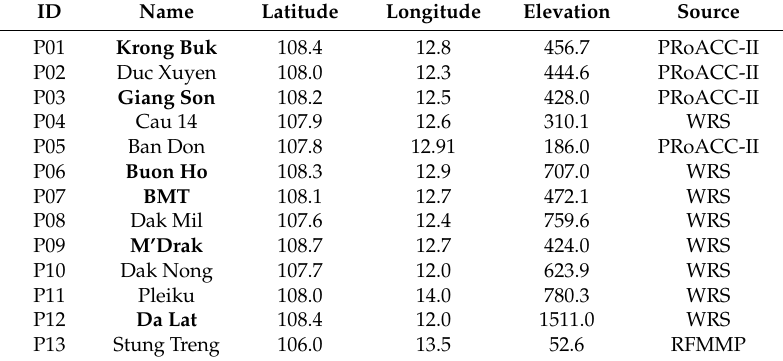
Table 1. Ground-based rainfall stations used in the research. In bold: stations used for the rainfall-runoff simulation of the Sre Pok